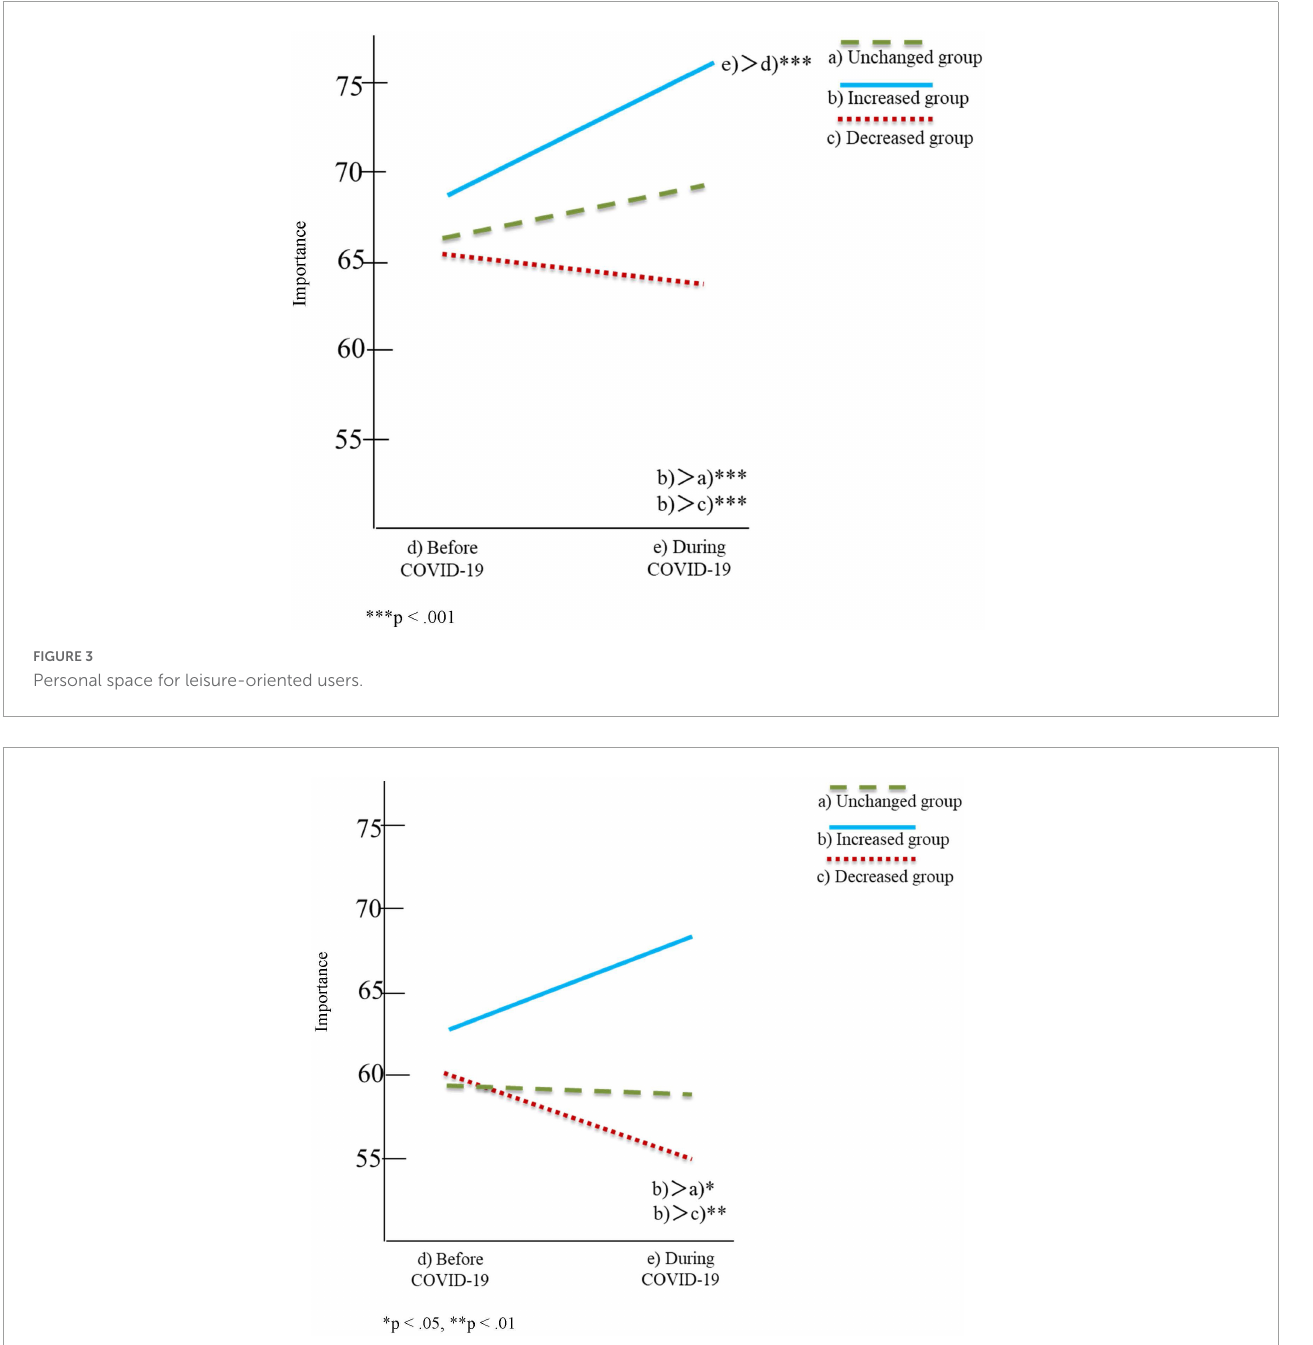
FIGURE4 Time spent with others for leisure-oriented users.